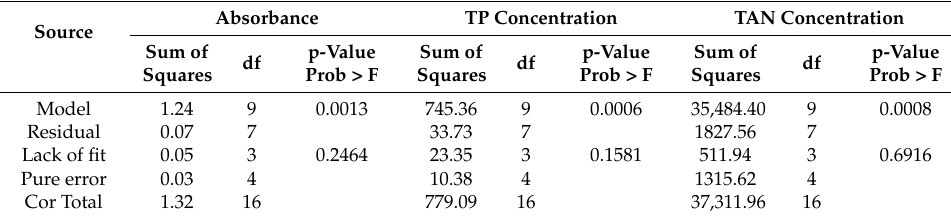
Table 3. ANOVA results for the absorbance, TP concentration and TAN